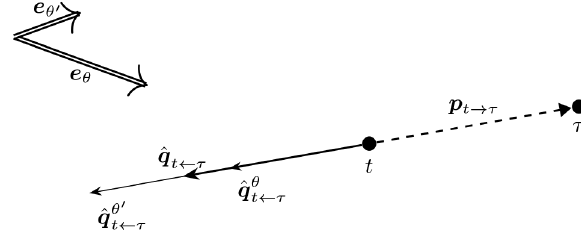
Figure 7. Illustration of how wind-direction-specific push-back pseudo-gradient vectors combine into an averaged push-back pseudo-gradient vector.